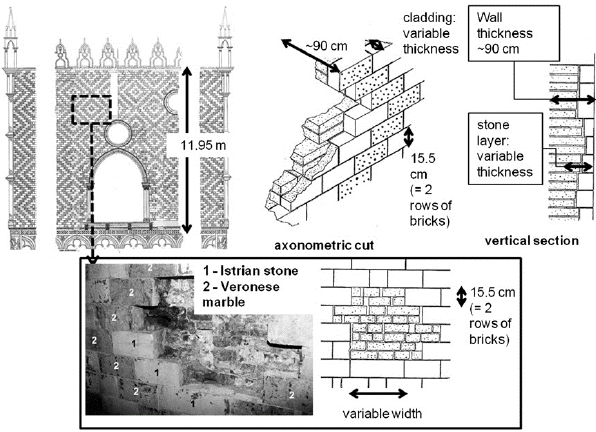
Figure 3. Details of the façade (Russo,